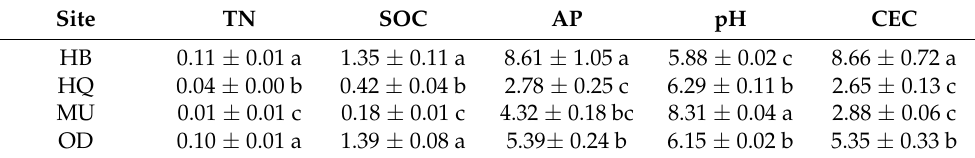
Table 2. Soil properties compared by ANOVA (mean values ±